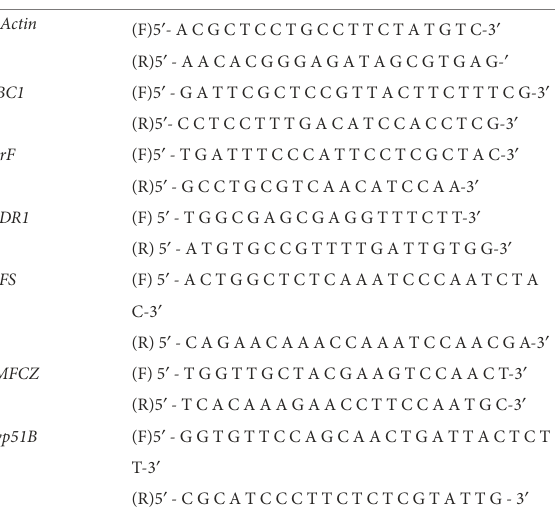
TABLE 1 Primer sequences of gene β -Actin , ABC1 , AtrF , MFS , MDR1 , and PMFCZ and